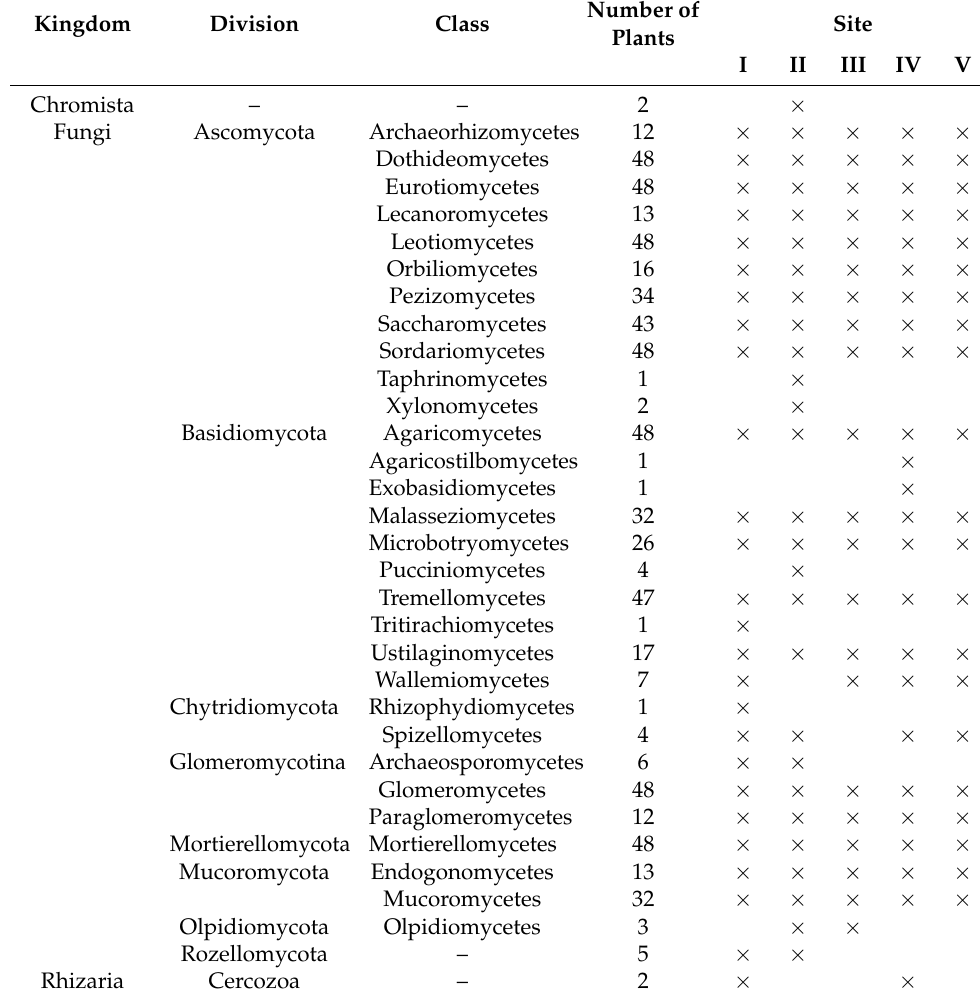
Table 1. Overview of the different classes of endophytes identified from Elymus repens roots from all sites. It lists the number of plants that contained each fungal class and in how many sites the class was